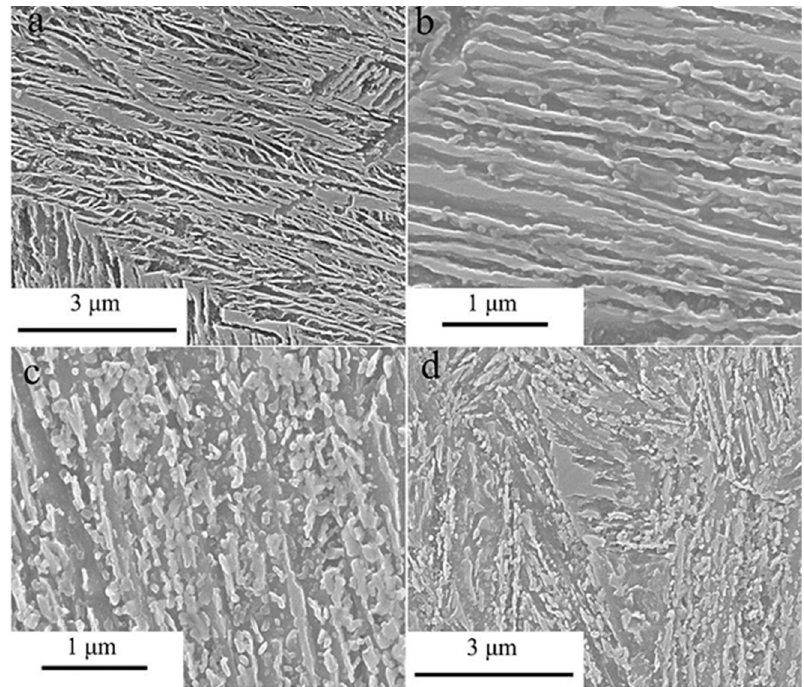
Figure 5. Microstructure of 0.82C–1.66Si–2.05Mn–0.22Cr–0.36Mo–1.06Ni steel. ( a ) Initial microstructure; ( b ) film-like morphology of the microstructure of the simulated low-energy welding process; ( c ) degraded microstructure for the simulated high-energy welding process; ( d ) area of blocky austenite for the high-energy welding process. Images produced via SEM [21].